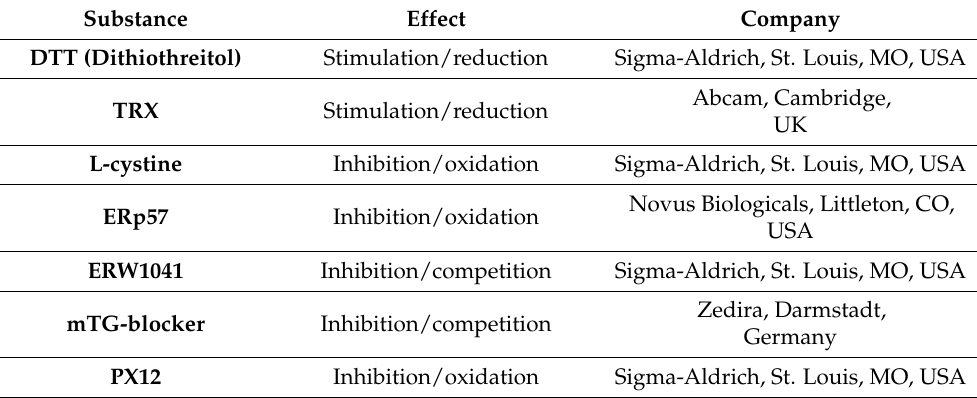
Table 2. List of the tested endogenous and exogenous substances for the in vitro assay. Substance